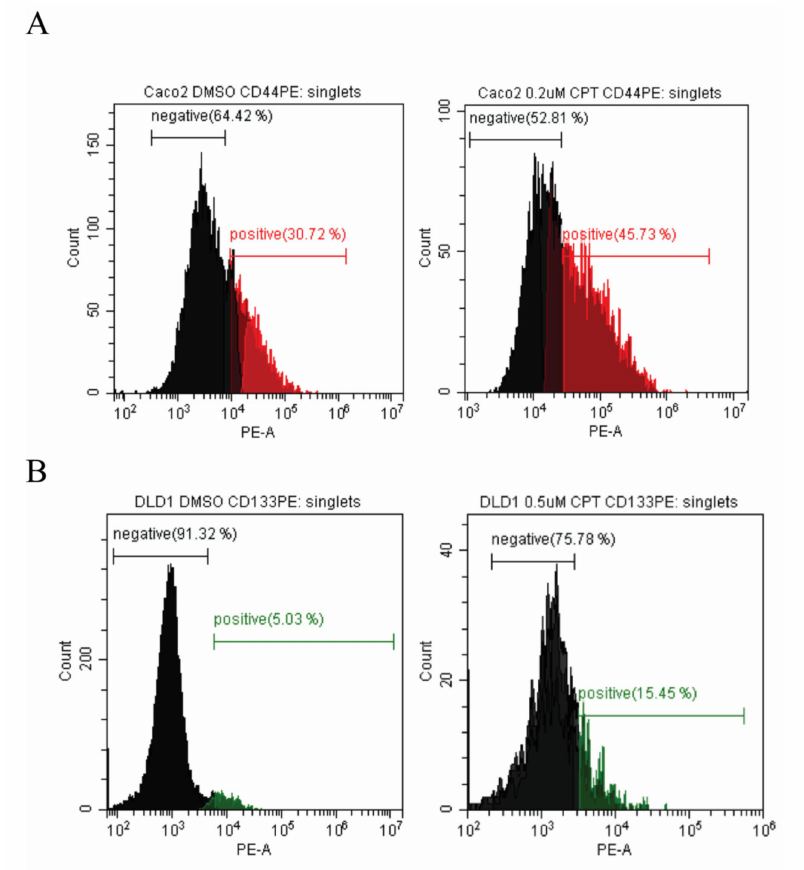
Figure 1. Flow-cytometry analysis of Caco2 and DLD1 before and after camptothecin treatment. The cells were treated with DMSO ( A and B , left panels) or indicated concentrations of camptothecin (CPT) ( A and B , right panels) for 72 h before labeling and flow-cytometry analysis. Cancer stem cell (CSC)-like Caco2 cells are shown in red ( A ) and CSC-like DLD1 cells are shown in green ( B